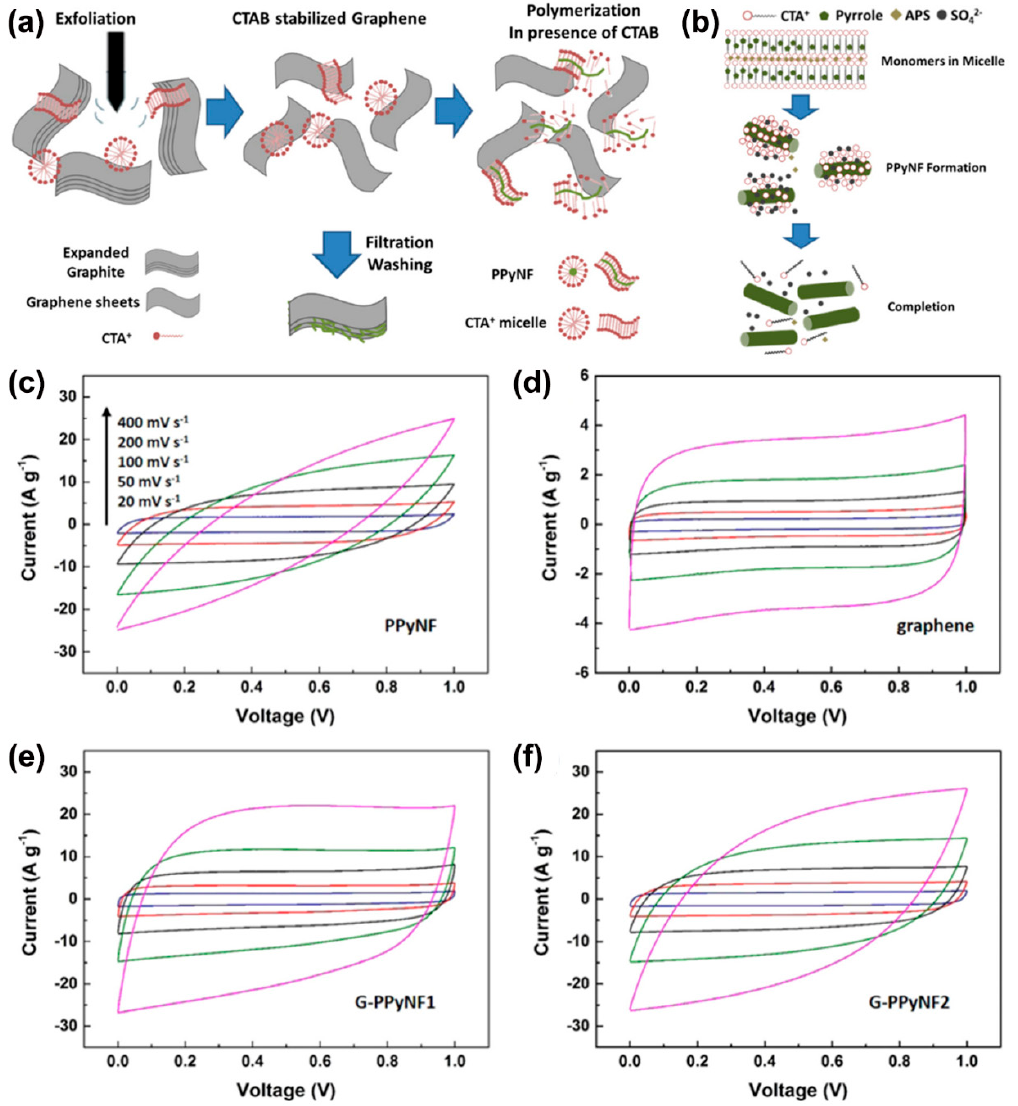
Figure 6. ( a ) The preparation scheme of G-PPyNF film; ( b ) Schematic illustration of the formation of PpyNF; CV curves of PPyNF ( c ), graphene ( d ), G-PPyNF1 ( e ), and G-PPyNF2 ( f ) electrodes. Reproduced with permission from [63]. American Chemical Society (2018).